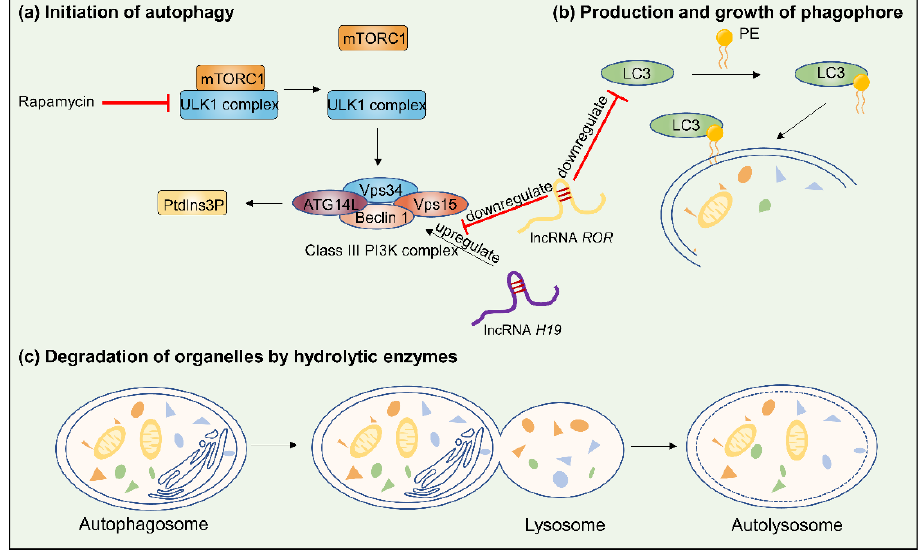
Figure 4. Summary of the steps involved in autophagy (lncRNA H19 and ROR are used as examples for clarifying the mechanism). Autophagy is initiated by the stepwise engulfment of cellular materials by the phagophore, which sequesters materials in double-membraned vesicles known as autophagosomes [80]. ( a ) When mammalian target of rapamycin (mTOR) is inhibited, mTOR complex 1 (mTORC1) isolates from the ULK1 complex. The first step of vesicle nucleation is activating Vps34, a class III phosphatidylinositol 3-kinase (PI3K), to produce phosphatidylinositol-3-phosphate (PtdIns3P). ( b ) A part of the vesicle elongation process is to bind phosphatidylethanolamine (PE) to LC3. ( c ) The formation of autophagosomes is completed after closure of the phagophore double membrane, and then autophagosomes fuse with lysosomes, resulting in degradation of the